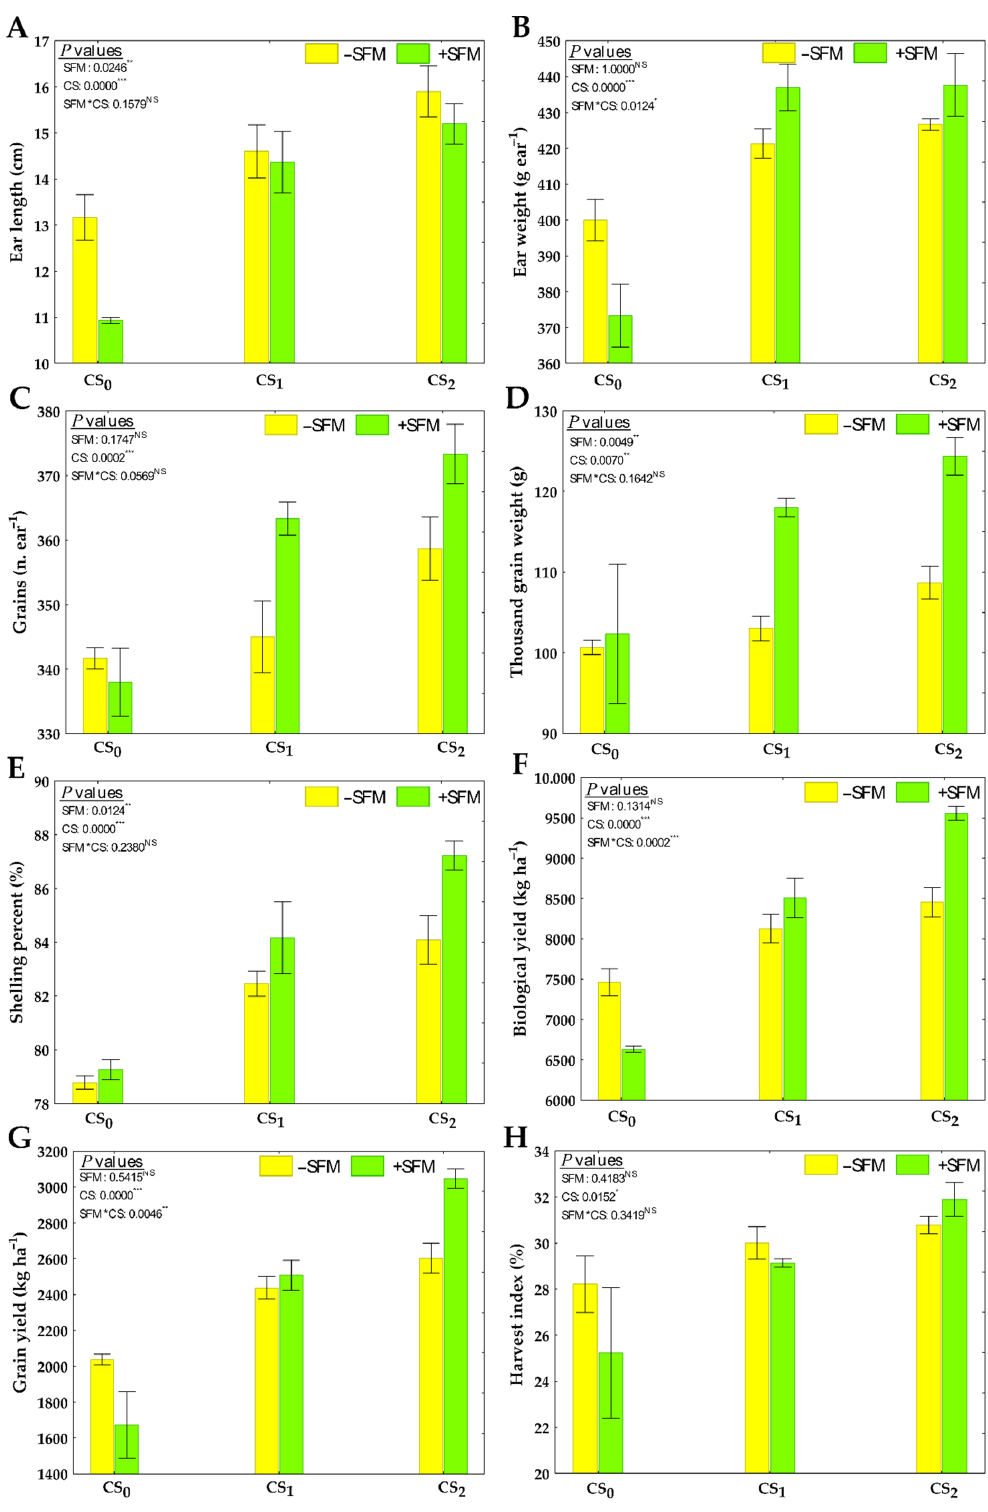
Figure 4. Yield components of sweet maize as affected by the compost source and sugarcane filter mud application. Ear length ( A ), ear weight ( B ), grain per ear ( C ), thousand grain weight ( D ), shelling percentage ( E ), biological yield ( F ), grain yield ( G ), harvest index ( H ). CS 0 = control treatment with no CS input; CS 1 = crop residues (Brassica residue); CS 2 = domestic wastes (household waste); − SFM = sugarcane filter mud not applied; +SFM = sugarcane filter mud applied. Bars represent ± SE ( n = 3). * 0.01 < p ≤ 0.05, ** 0.001 < p ≤ 0.01, *** p ≤ 0.001; NS: not